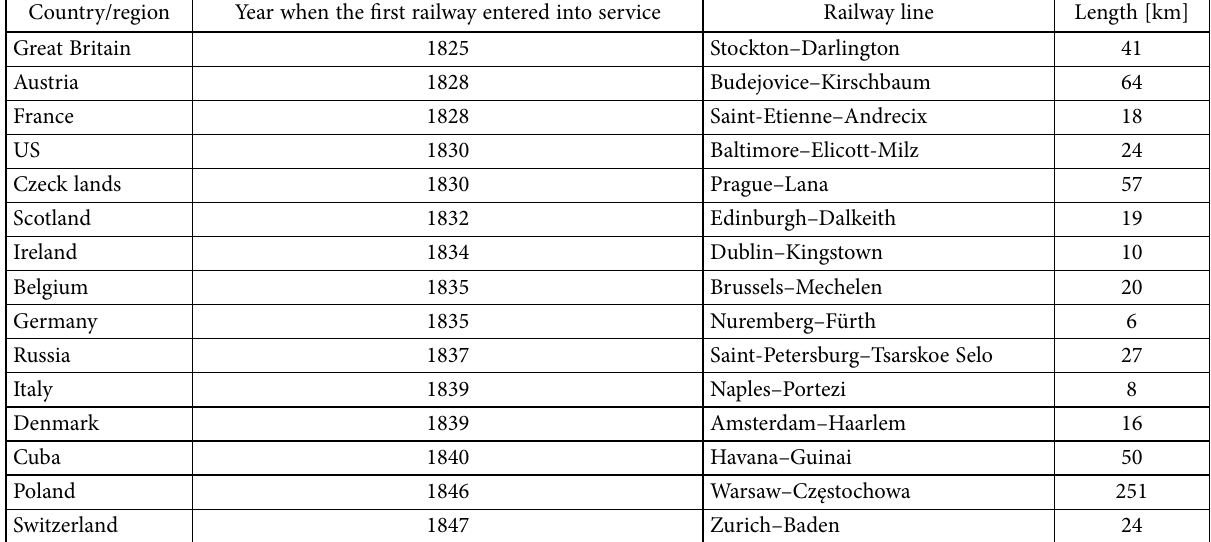
Table 1. World’s first railways – entry into service (Husainov